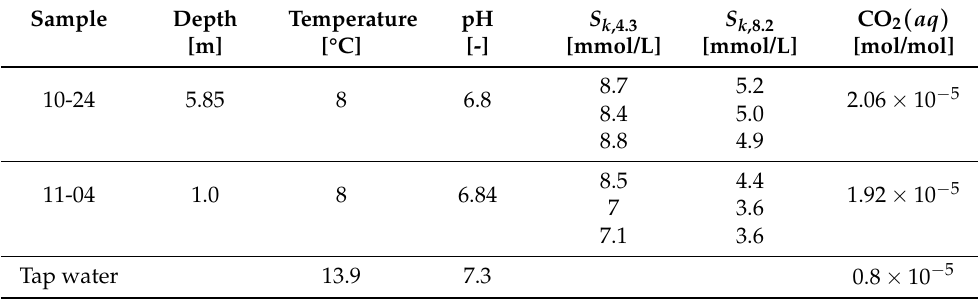
Table 1. Acid capacities in [mmol/L], aqueous CO 2 concentration, and water-chemistry parameters of water samples. In the Results section, we will use the median of the three titrations per sample in the frame of the control measurement campaign. Tap-water parameters are provided by LW (https://www.lw-online.de/trinkwasser-qualitaet, accessed on 2 February 2023). Calculation was done using Reaktoro